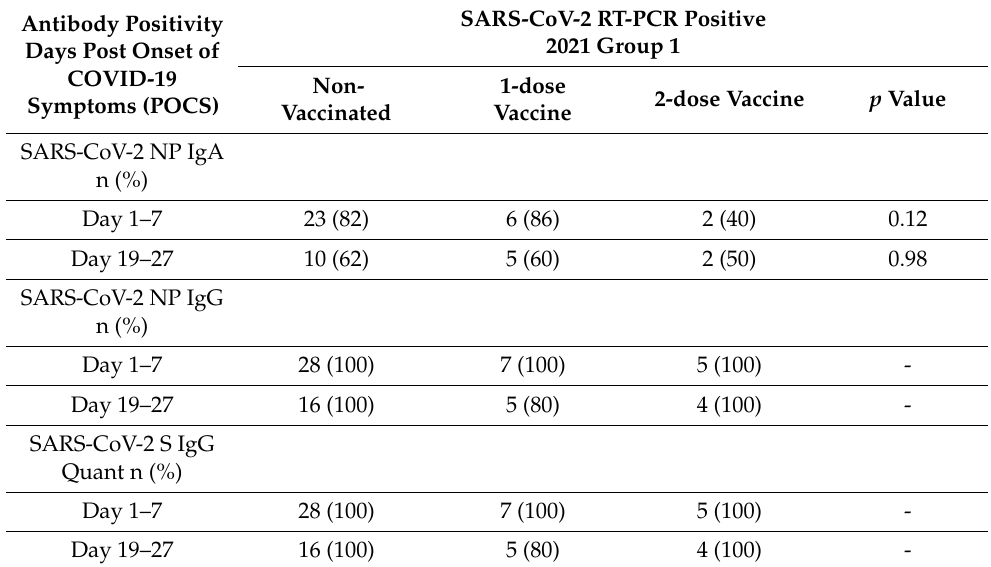
Table 2. Anti-SARS CoV-2 antibody responses during the Delta variant infection.